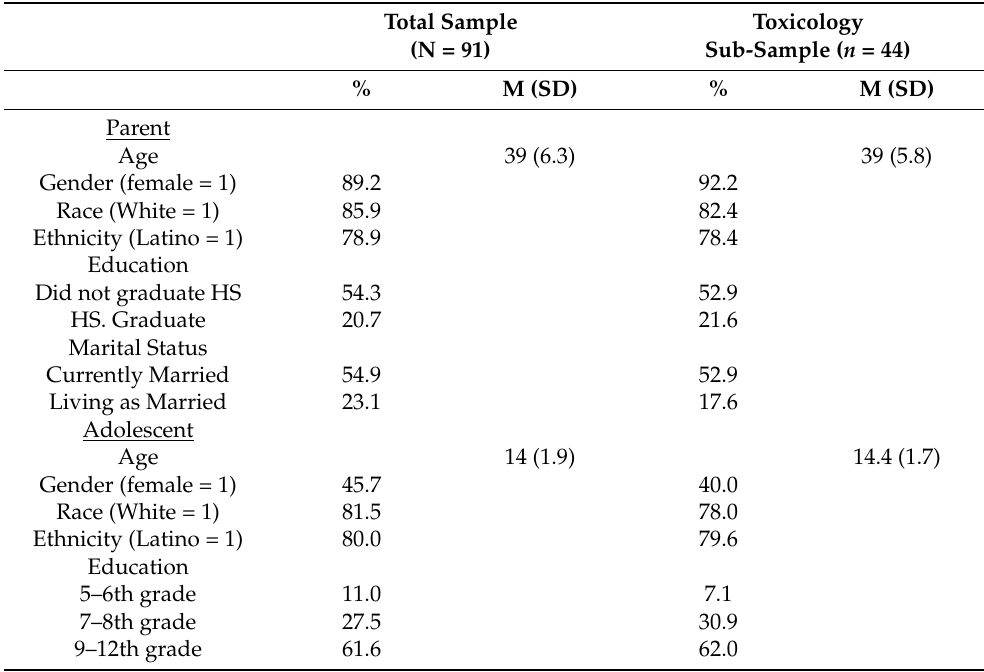
Table 1. Sample description of the parent study and the subsample who participated in the toxicolog- ical portion of the